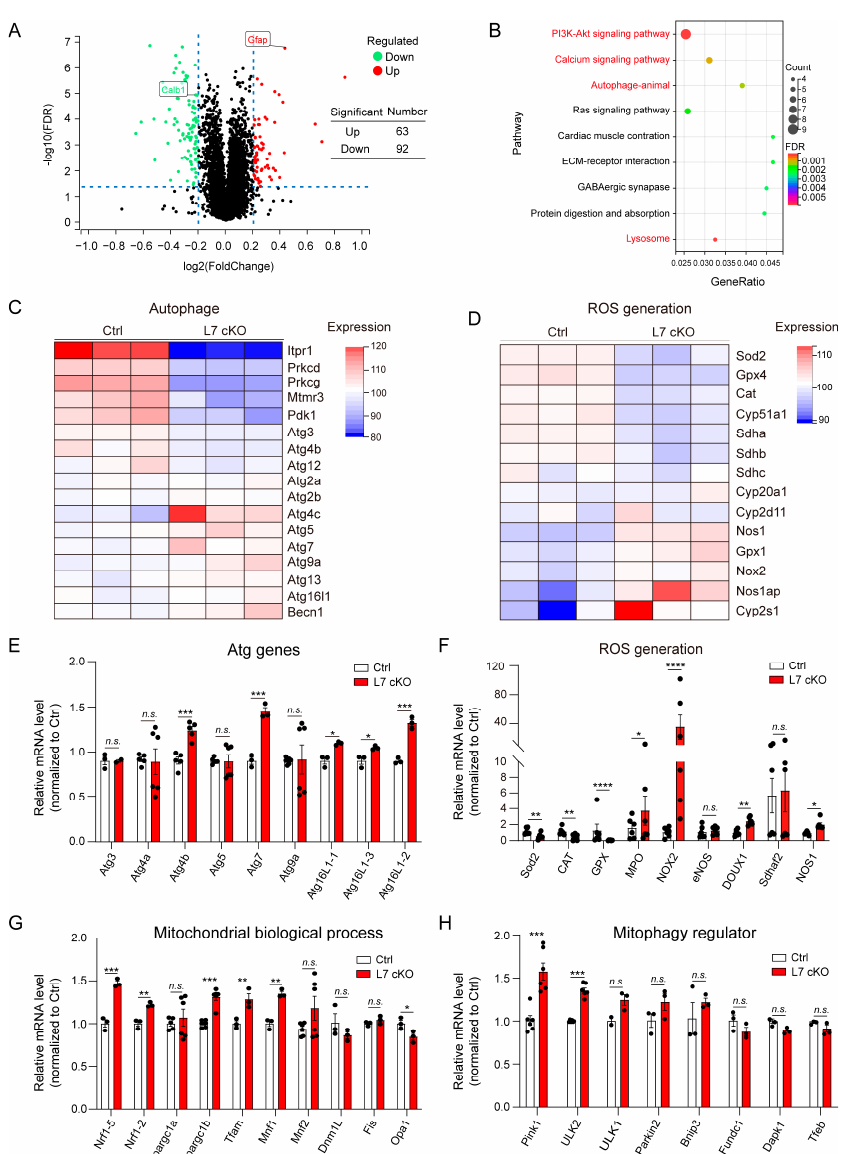
Figure 4. Ablation of OGT in PCs induces changes in the gene expression of mitochondrial autophagy and ROS accumulation in cKO mice. ( A ) Volcano map of differentially expressed proteins analyzed using TMT in the cerebellum of the Ctrl and cKO mice. ( B ) Curated KEGG pathway terms of up- or down-regulated proteins in the cerebellum of the cKO mice compared with Ctrl mice. The pathways closely related to autophagy are marked in red. ( C , D ) Heatmap of the expression of pro- teins in autophagy ( C ) and ROS generation ( D ) signaling pathways. The mean expression levels in the heatmap were standardized by taking the z-score within each row (n = 3). The top bar indicates the genotypes of the samples. ( E , F ) Quantitative RT-PCR analysis indicates signi fi cant changes in Atg-related genes ( E ) and ROS generation ( F ) in the cerebellum of the Ctrl and cKO mice (mean ± SEM; * p < 0.05, ** p < 0.01, *** p < 0.001, **** p < 0.0001, n.s. = no signi fi cance, n > 3). ( G , H ) Quantitative RT-PCR analysis indicates signi fi cant changes in mitochondrial biological processes-related genes ( G ) and mitophagy-related genes ( H ) in the cerebellum of the Ctrl and cKO mice (mean ± SEM; * p < 0.05, ** p < 0.01, *** p < 0.001, **** p < 0.0001, n.s. = no significance, n > 3).